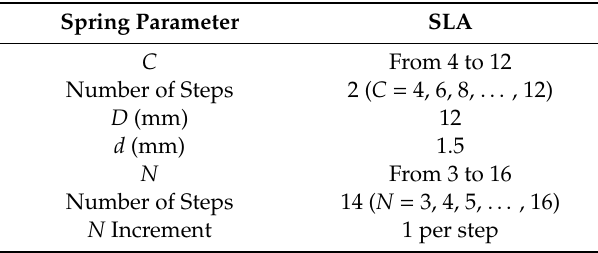
Table 4. Simulation parameter for